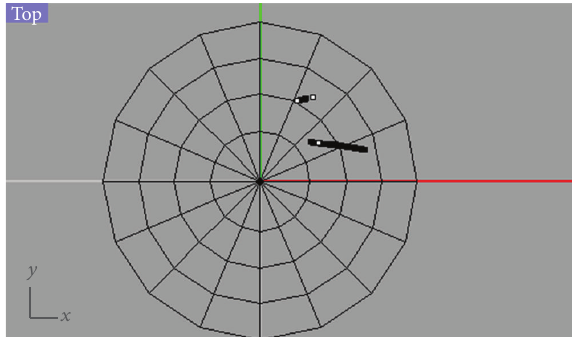
Figure 6: Top view of the simple reflection points obtained with function (1) or (3).